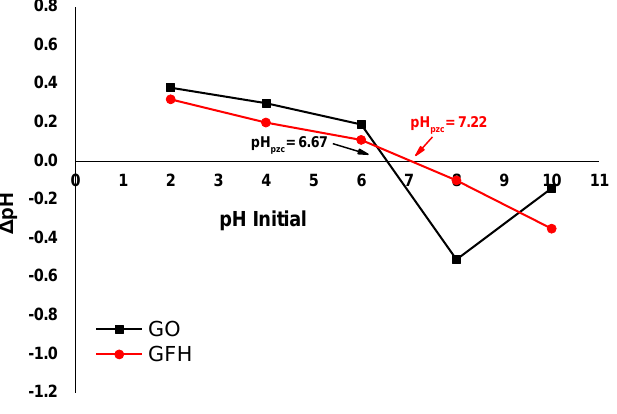
Figure 4. Determination of pH pzc of GO and GFH using pH drift method.